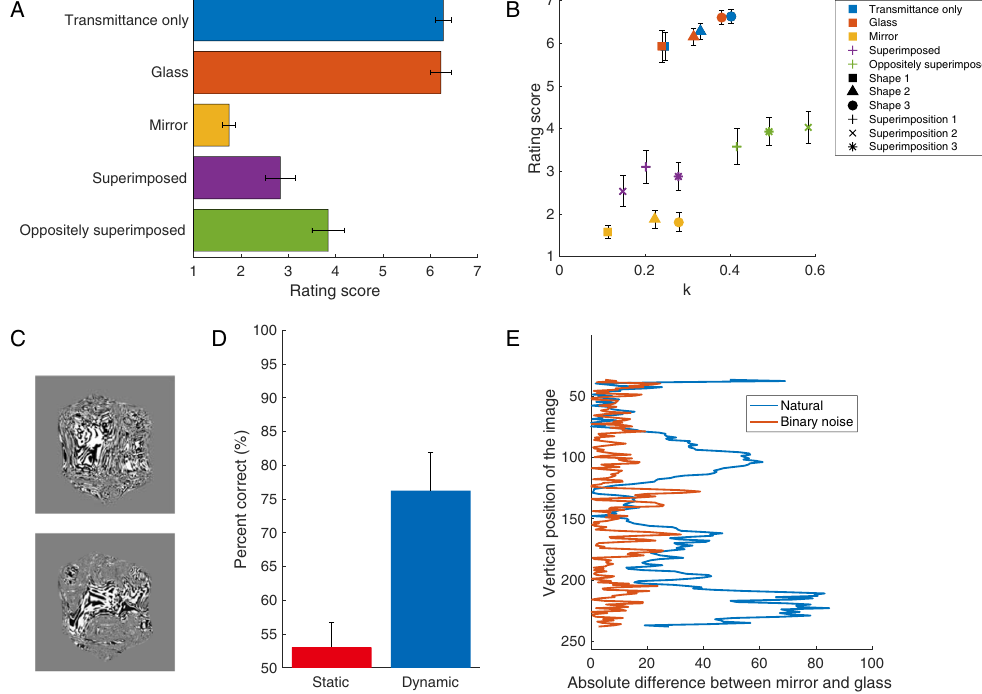
Figure 5. Validation of the proposed model with new stimuli. ( A ) Rating scores of perceived specular reflection and transparency for new stimuli. The horizontal axis indicates the rating score corresponding to the vertical axis of Fig. 4A. The vertical axis indicates the stimulus conditions. The error bars represent the standard error of the mean across all ten observers. ( B ) Relationship between model output and rating score. ( C ) Stimuli rendered in random binary noise illumination (top: mirror, bottom: glass). See also, Movie 4A and B. ( D ) Result of perceptual material discrimination using the binary noise condition. The horizontal axis indicates each condition. The vertical axis indicates the percentage of correct answers. Averages and standard errors among observers were obtained. The error bars represent the standard error of the mean across all seven observers. ( E ) Different luminance distributions between original and the binary noise conditions. The horizontal axis indicates the absolute differences of the image pixel intensities (luminance) between mirror and glass. The pixel intensities were averaged along each row in the image, excluding the background. The vertical axis indicates the vertical position of the